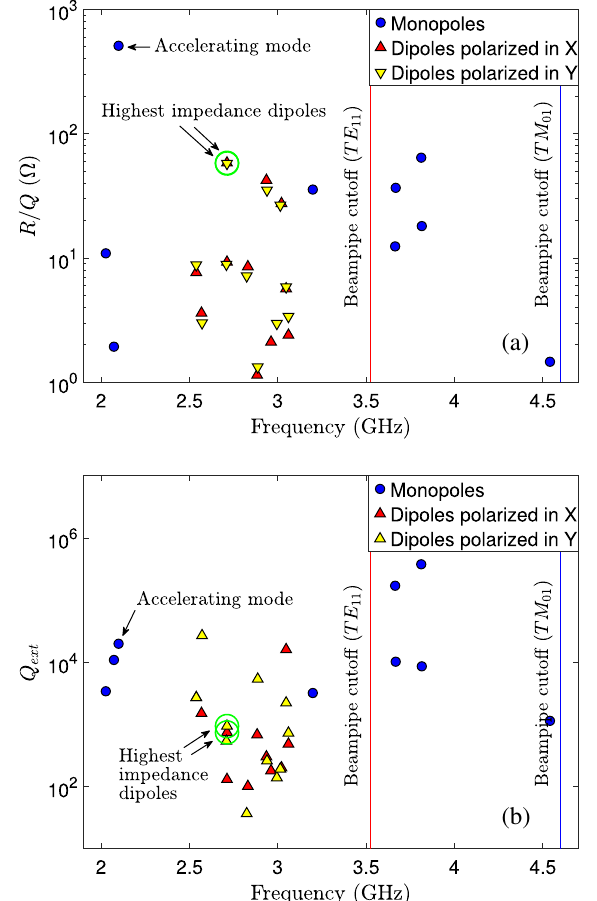
FIG. 6. Shunt impedances (a) and external Q factors (b) for monopoles and dipoles in the five-cell PBG cavity (simulation). Only modes with R=Q ≥ 1 Ω are shown.